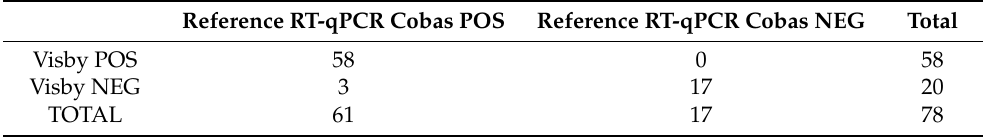
Table 1. Sensitivity and specificity of the Visby device.